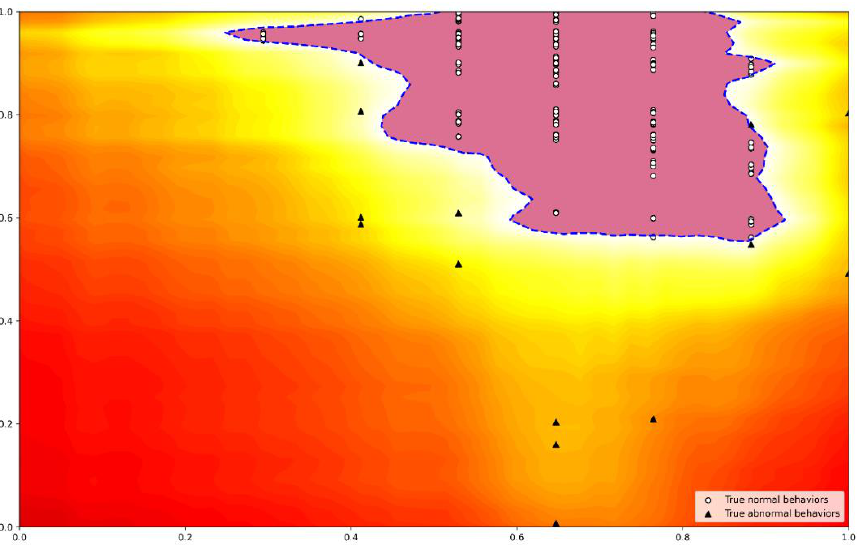
Figure 9. Distribution of data based on anomaly score contour.